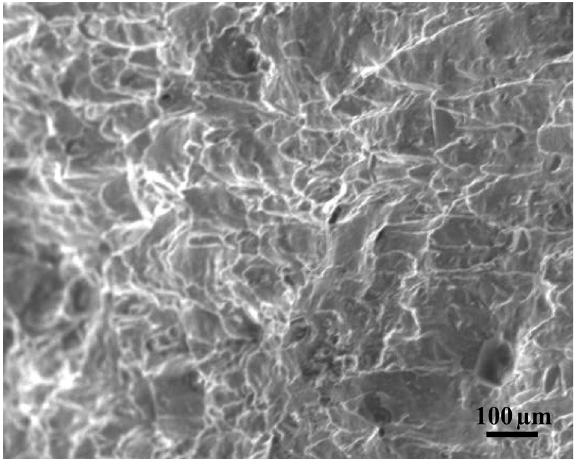
Figure 5: Fractographic examination of failed primary superheater